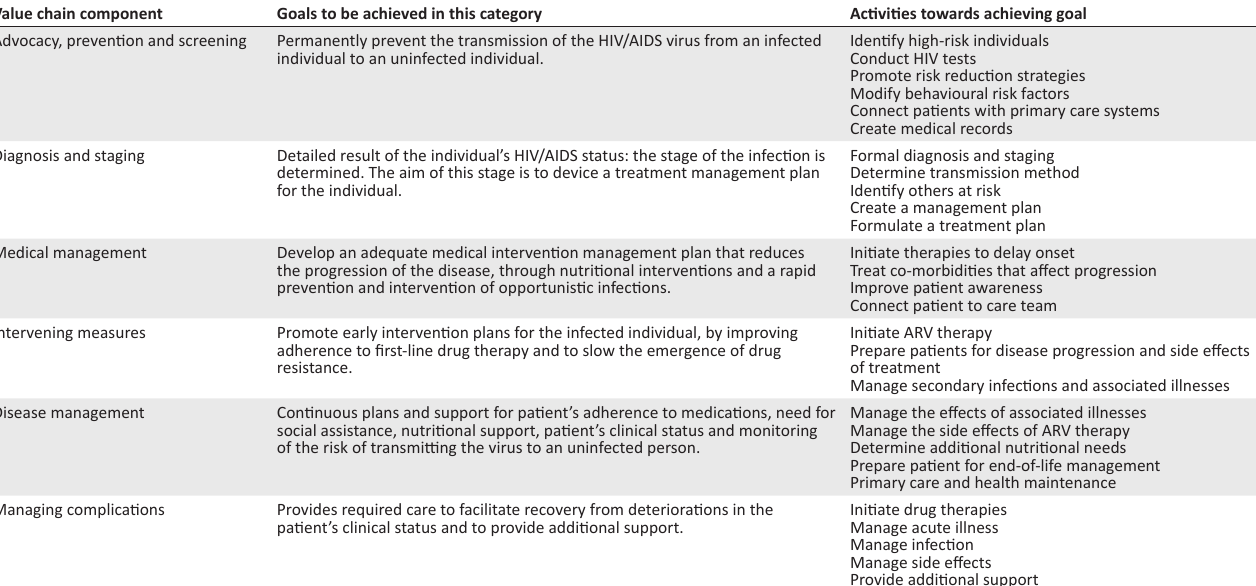
TABLE 1: The HIV/AIDS value chain for service delivery and care. Value chain